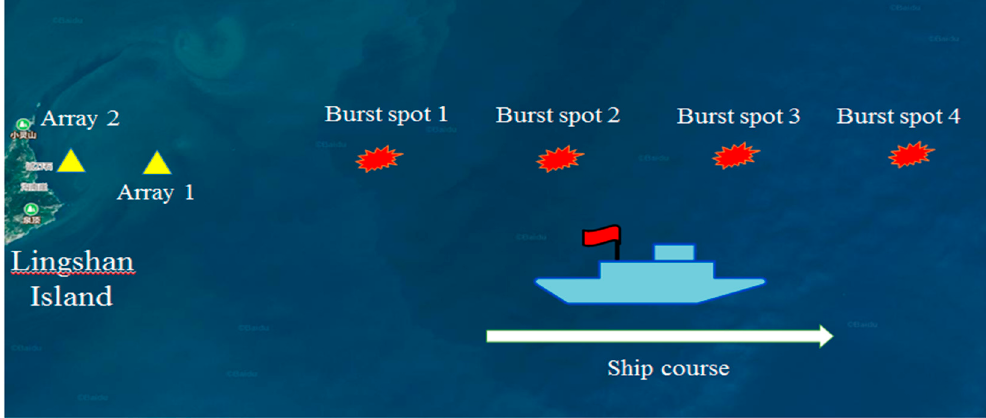
Figure 11. Navigation trajectory of the experimental ship and localization of the receiving